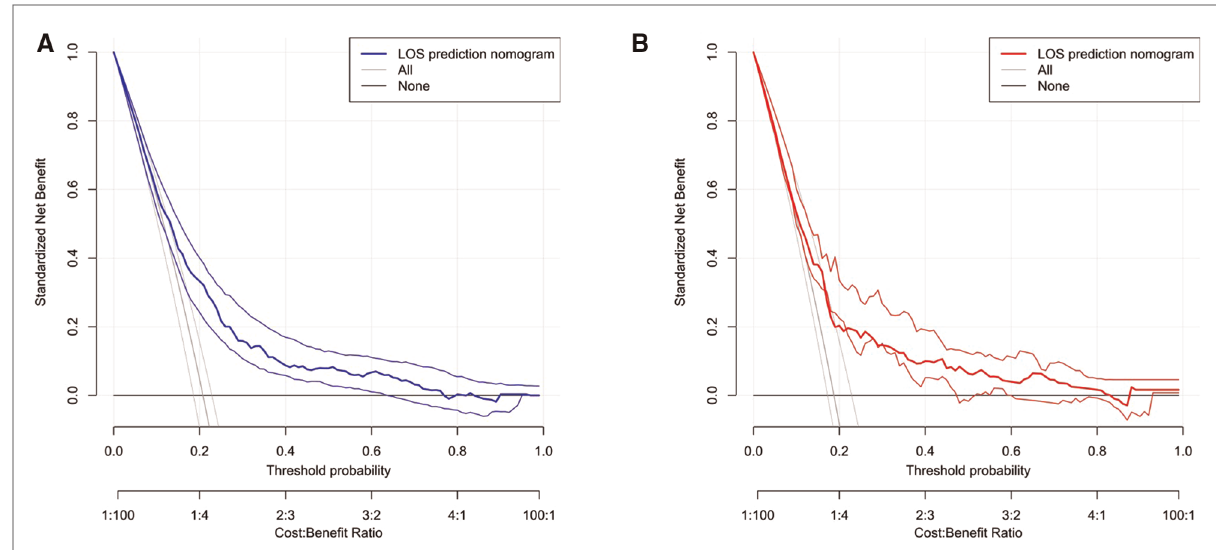
FIGURE 5 The DCA curve of prolonged hospital stay in the training set ( A ) and validation set ( B